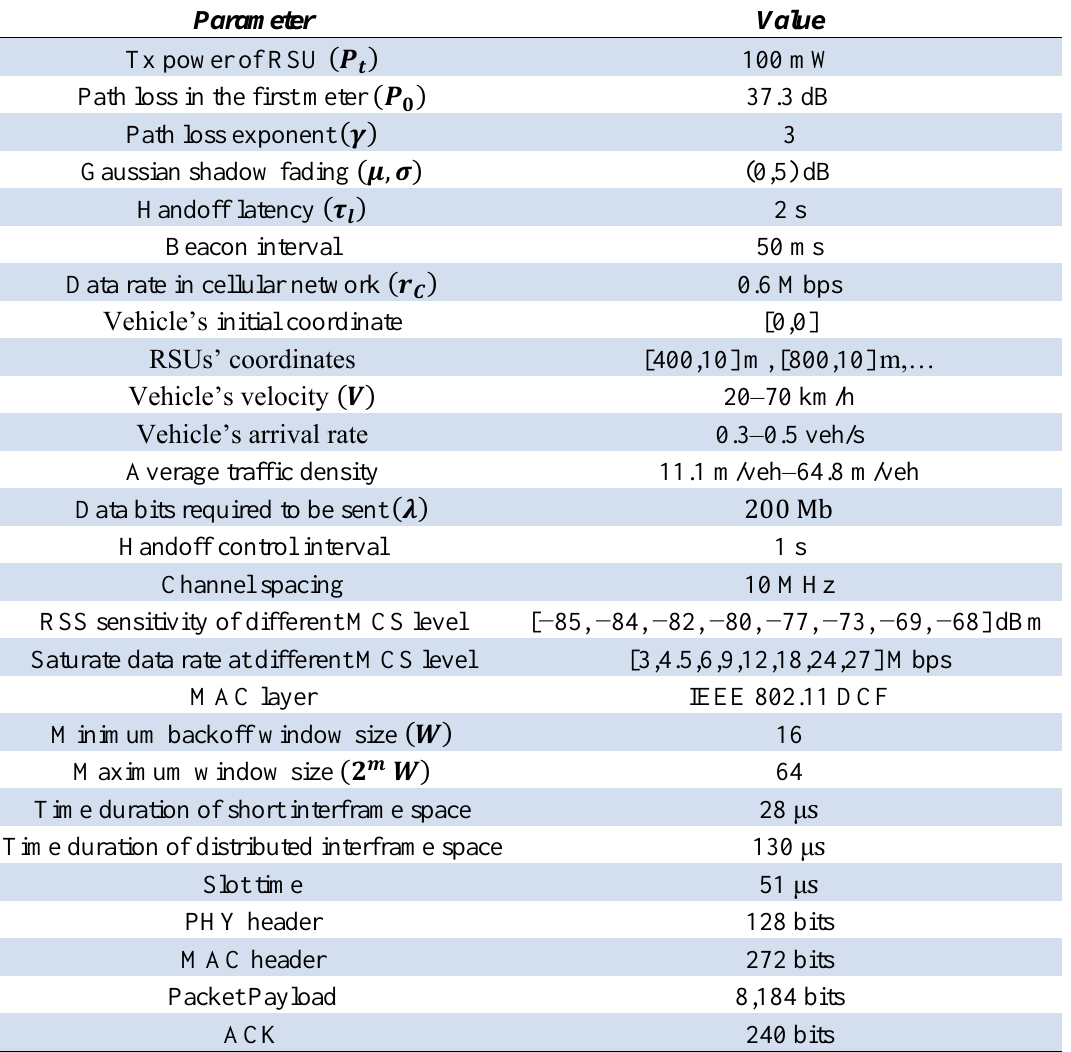
Table 2. Simulation